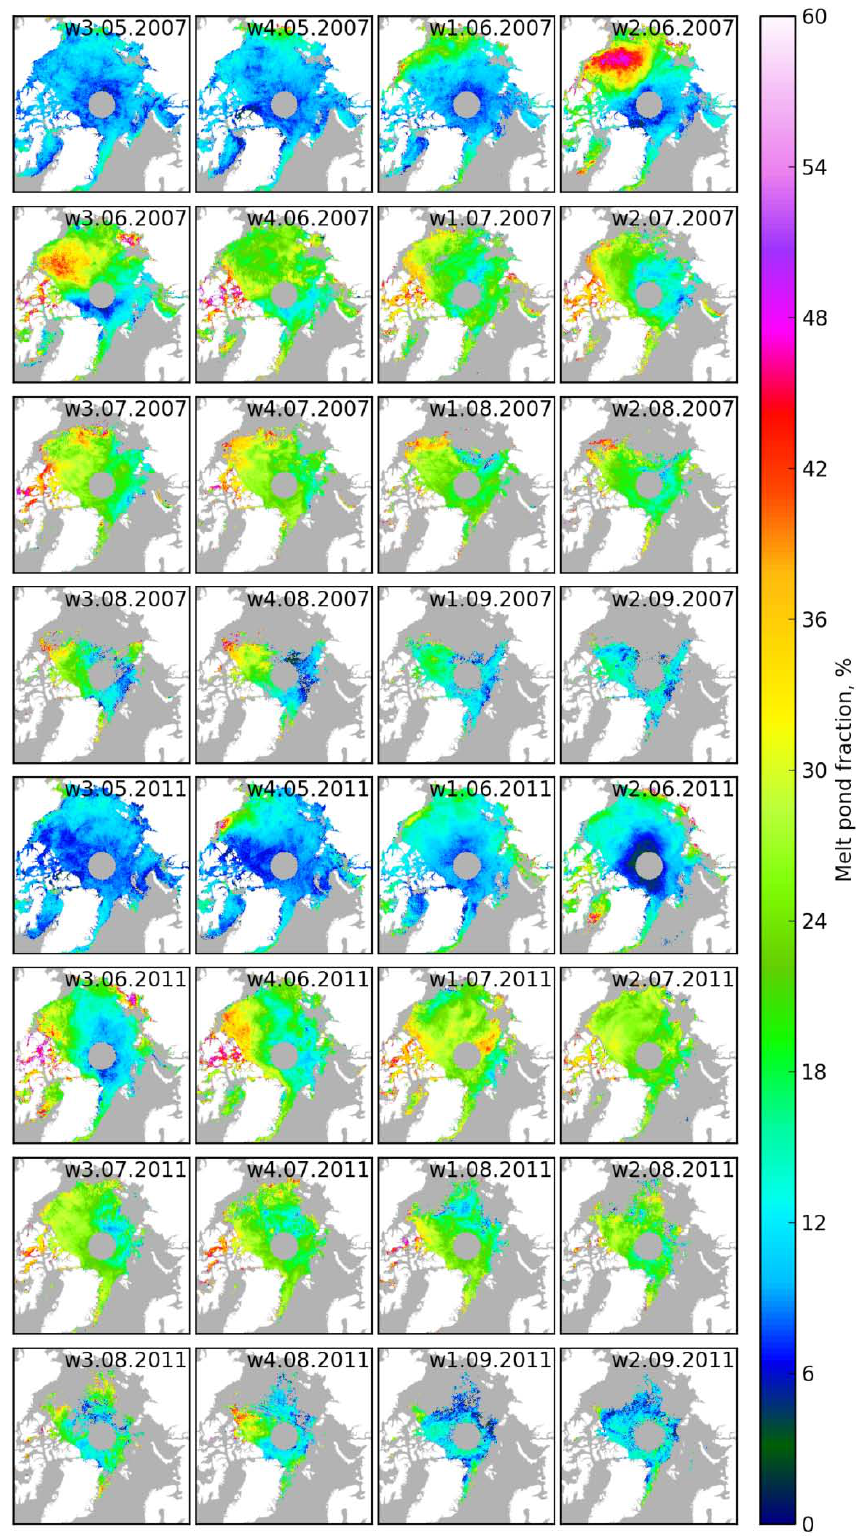
Figure 3. Retrieved weekly averaged MPF for summer 2007 and